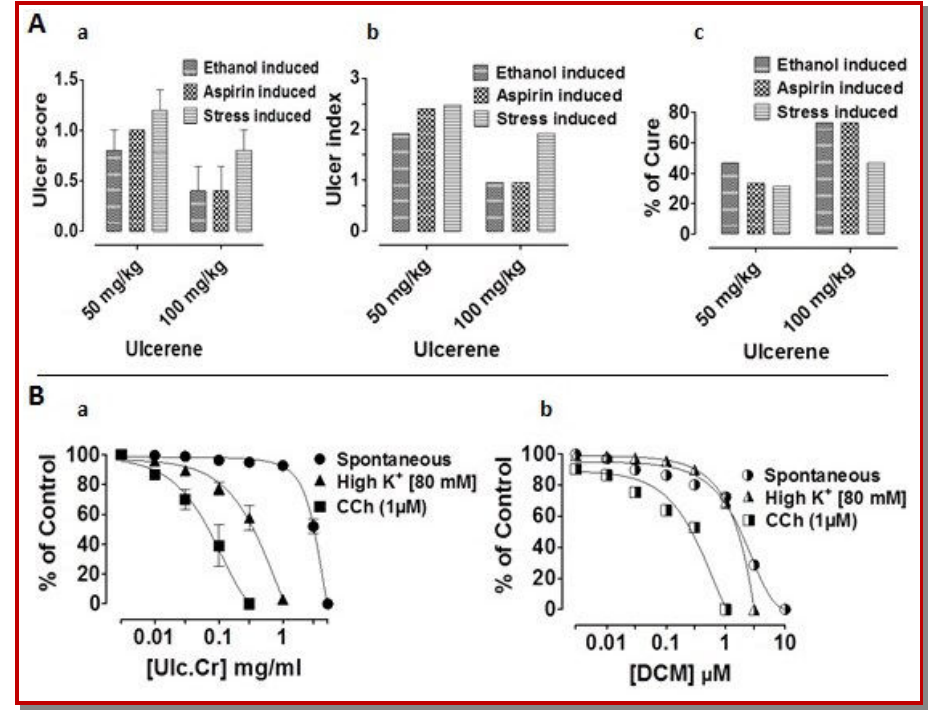
Figure 2: (A) Bar-chart showing comparison of (a) ulcer scores, (b) ulcer index and (c) percentagecure of ulcerene (50 and 100 mg/ kg) treated groups in different ulcer models and (B) relaxant effect of (a) Ulc.Cr (crude extract of ulcerene) and (b) dicyclomine (DCM) on spontaneously contracting and of high K + [80 mM] or CCh (1 µM) contractionof rabbit jejunum preparations. Values expressed with mean ± SEM., n=3 –